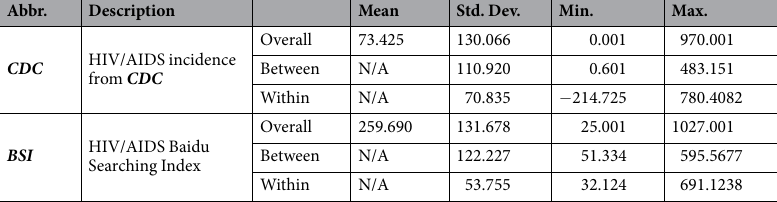
Table 1. Descriptive statistics for